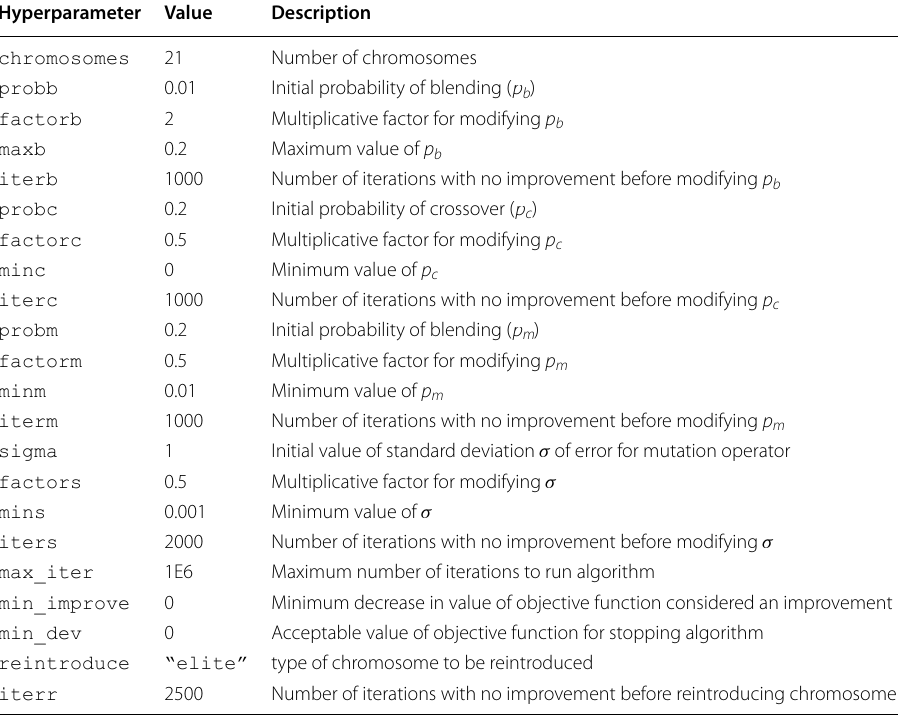
Table 1 Simulation study